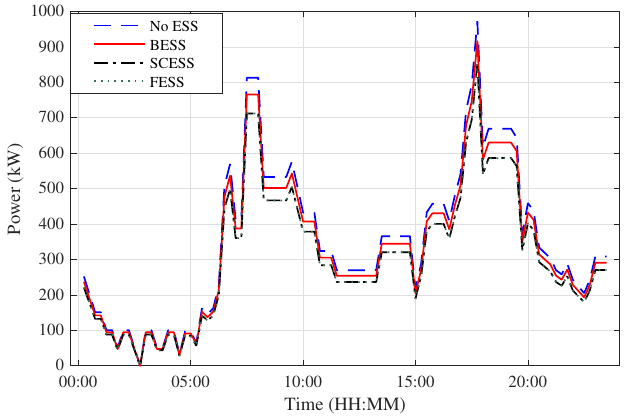
Figure 19. 24 h profile for 15% saving of regenerative braking energy.